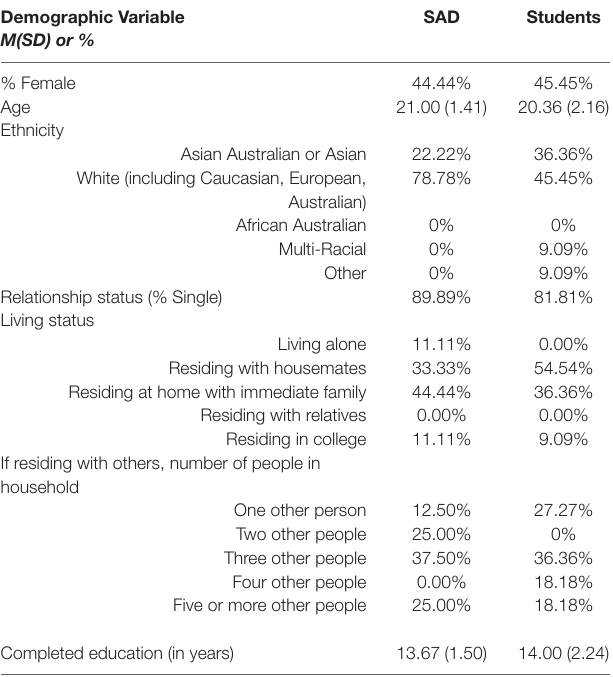
TABLE 1 | Demographics of participants across groups. Demographic Variable M(SD) or %